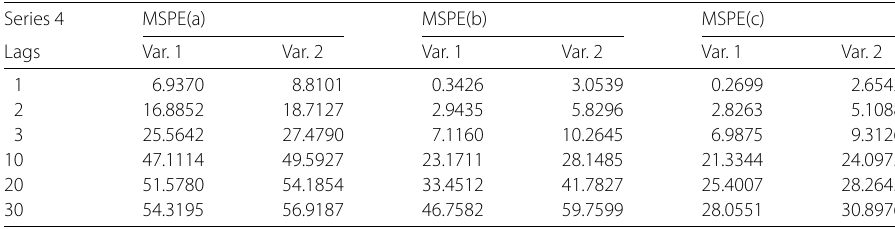
Table 4 Pure VECM model (Series